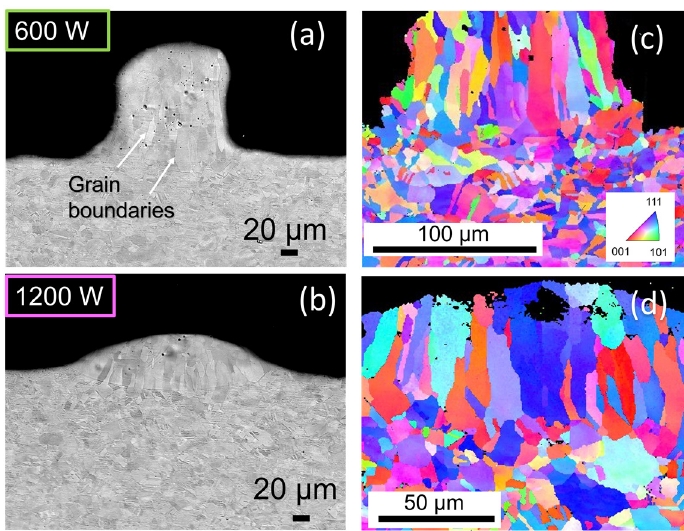
Figure 6. Backscattered SEM images of the samples and inverse pole figure IPF demonstrating the crystallographic orientation of the grains: ( a , c ) for C-600 and ( b , d ) for C-1200, respectively. The ori- entation color map is common for ( b , d